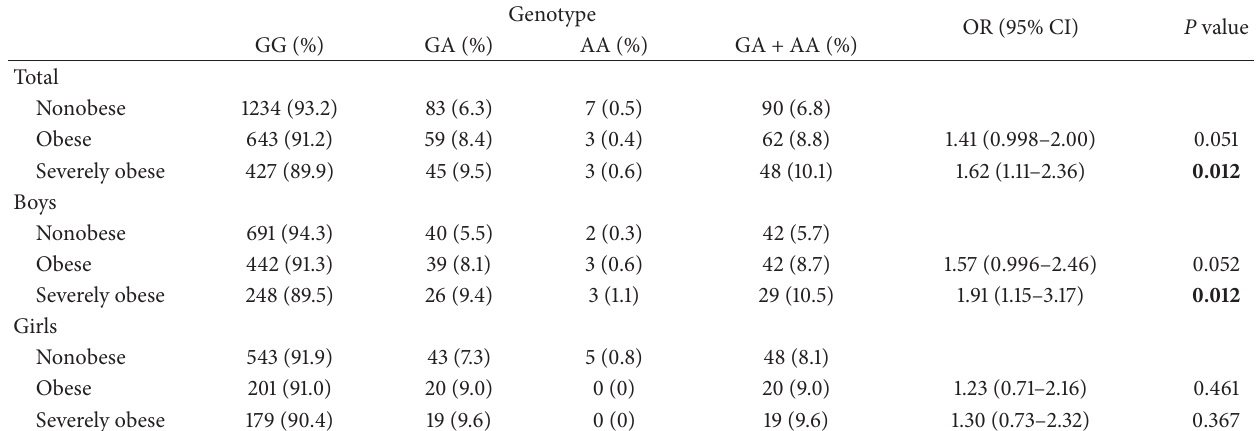
Table 2: Association of the INSIG2 -102G > A polymorphism with